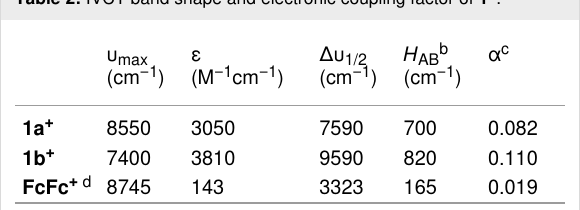
Table 2: IVCT band shape and electronic coupling factor of 1 + .